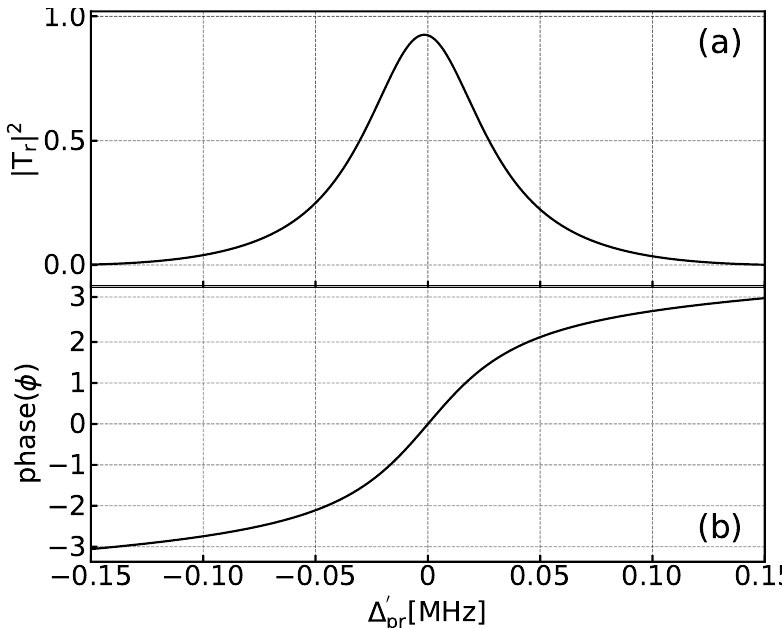
Figure 3. ( a ) Plot of transmission coefficient | T r | 2 (magnified transparency window) of the probe laser power as a function of the effective probe-cavity detuning ∆ (cid:48) pr = ω pr − ω (cid:48) c when the pump laser field E pu = 0.035MHz. ( b ) Phase plot of the transmitted probe beam as a function of the effective probe-cavity detuning ∆ (cid:48) pr for pump laser field E pu = 0.035MHz. The other parameters are the same as in Figure 2.